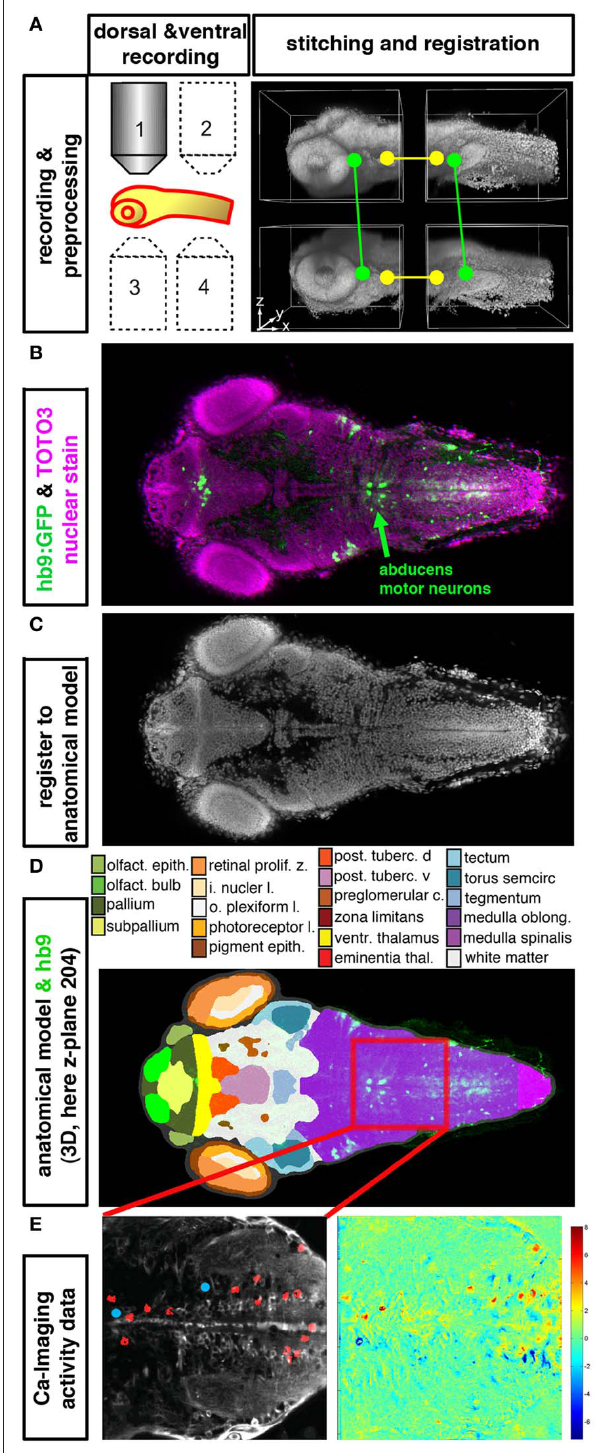
FIGURE 2 | Integration of anatomical, gene expression, and functional information in 3D. (A–E) High resolution datasets generated using an anatomical reference stain for each developmental stage may serve to establish an anatomical reference to register different data types into an anatomical and functional atlas of the nervous system. The Virtual Brain